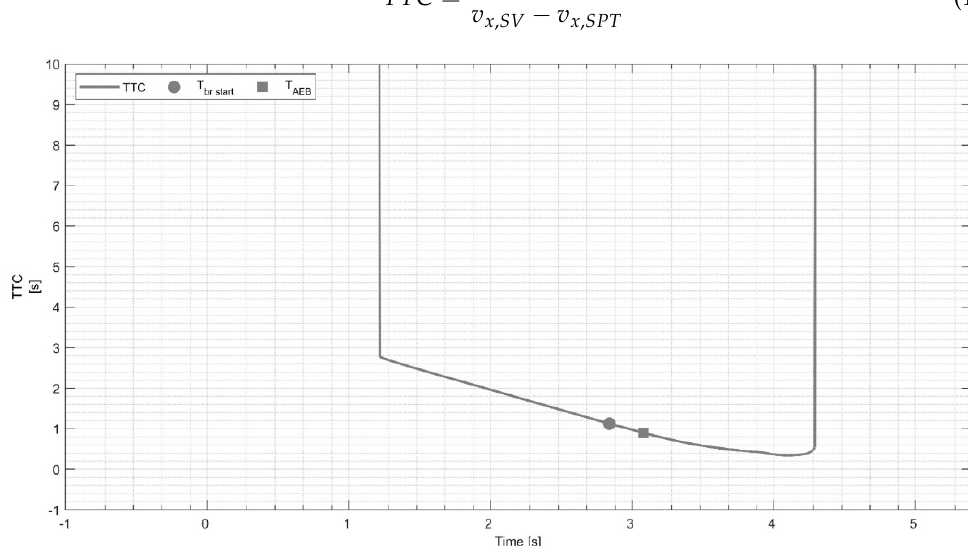
Figure 24. Time-to-collision longitudinal signal.